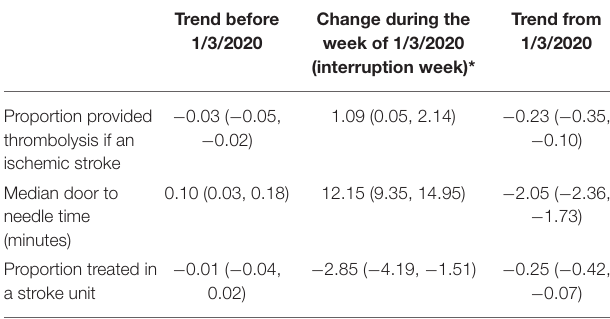
TABLE 3 | Changes in the provision of acute stroke care assessed using interrupted time series